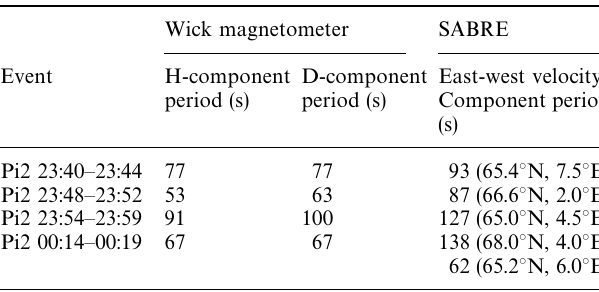
Table 5. Wick magnetometer